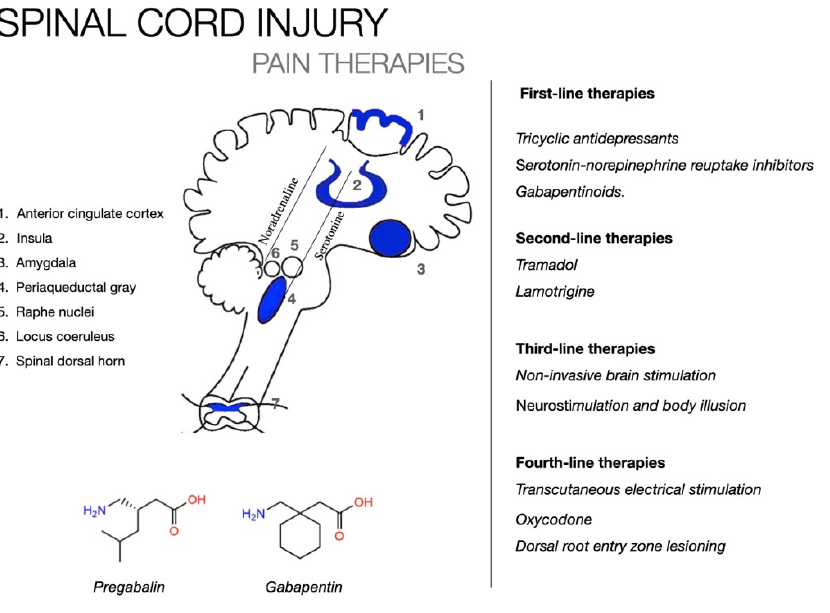
Figure 2. Treatment types of neuropathic pain following spinal cord injury. Local anesthetics and N ‐ methyl ‐ d ‐ aspartate (NMDA) antagonists are used to de ‐ crease abnormal excitability [92]. Parenteral administration of the sodium channel blocker